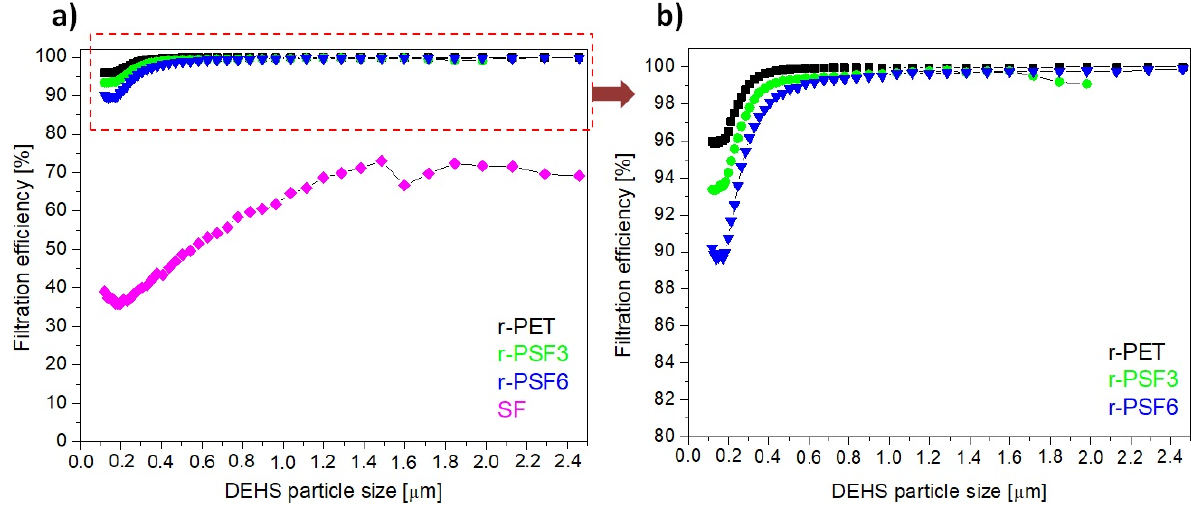
Figure 8. Filtration efficiency of investigated samples with basis weights between 1.75–3.23 g · m − 2 ; ( a ) r-PET (black sign), r-PSF3 (green sign), r-PSF6 (blue sign), SF (magenta sign); ( b ) detail of the curves at high efficiency.